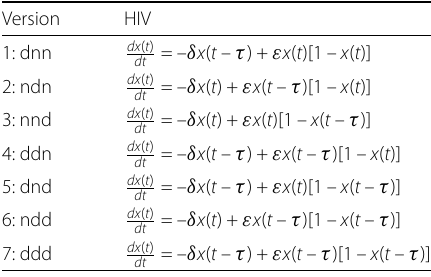
Table 1 Time-delay differential equation